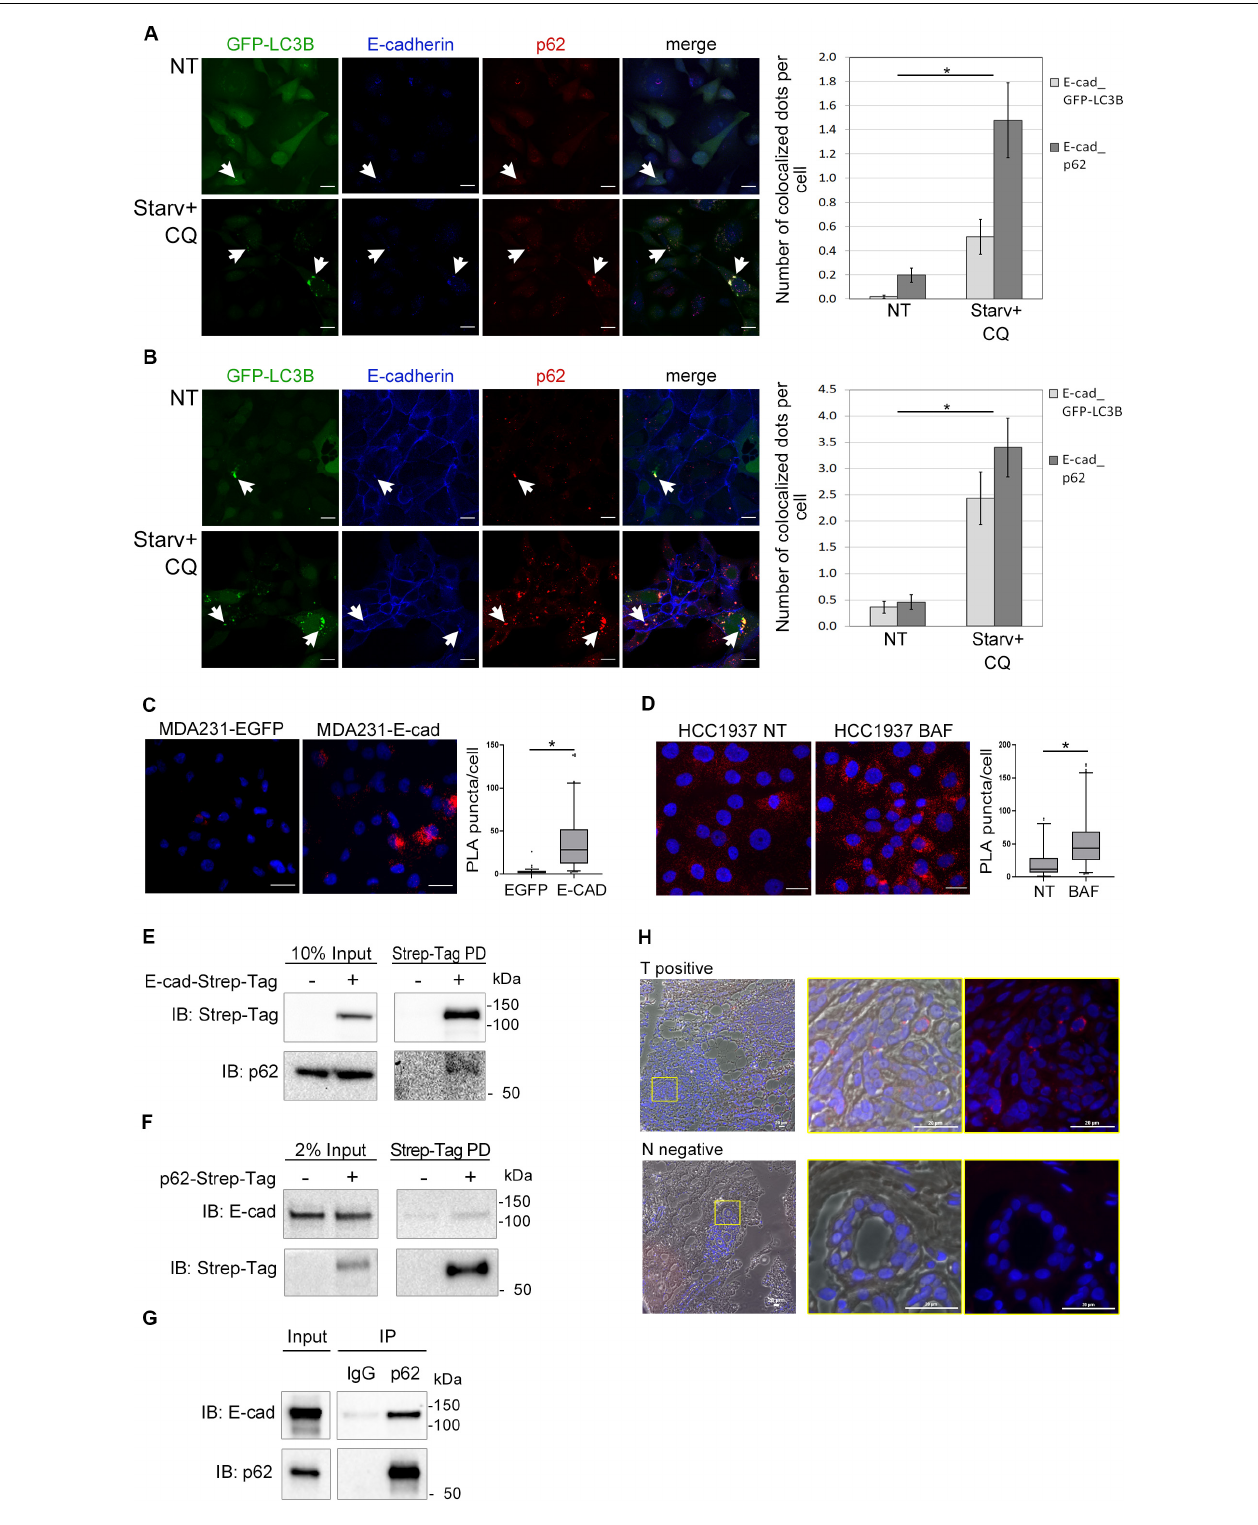
FIGURE 4 | E-cadherin and SQSTM1/p62 interaction. (A,B) Representative confocal images of MDA231-GFP-LC3B (A) and HCC1937-GFP-LC3B (B) cell lines untreated (NT) or starved in the presence of CQ (Starv+CQ) for 8 h. Cells were stained with rabbit anti-E-cadherin/AlexaFluor 633 (E-cadherin) and anti- SQSTM1/p62/AlexaFluor 594 (p62) antibodies. Individual and merged fluorescence images are reported on the left. Arrowheads indicate representative spots of